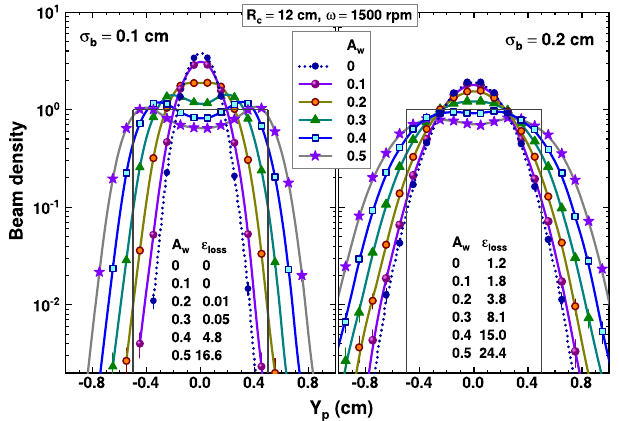
FIG. 14. Beam-density distributions integrated over X p within the 1-cm arc length for the target with R c ¼ 12 cm are shown for the indicated velocity ω , wobbling amplitude A w (in cm), and beam widths σ b (symbols connected by lines). These distributions are compared to the uniform distribution with the unit beam- density probability. Straight lines at Y p ¼ (cid:2) 0 . 5 cm correspond to the annulus width of the rotating target, which determines beam losses ε indicated in %. loss